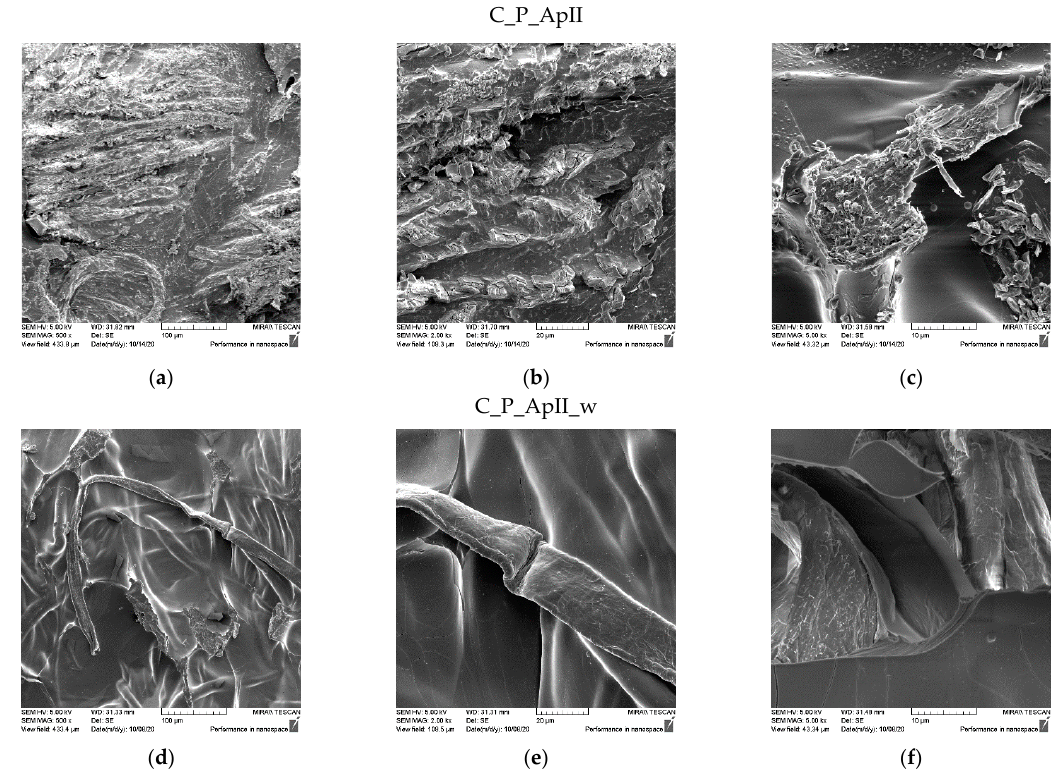
Figure 5. SEM micrographs of plain weave fabric samples treated with Bath II before (C_P_ApII) and after washing (C_P_ApII_w) at different magnifications: ( a , d ) 500x, ( b , e ) 2000x, and ( c , f ) 5000x.